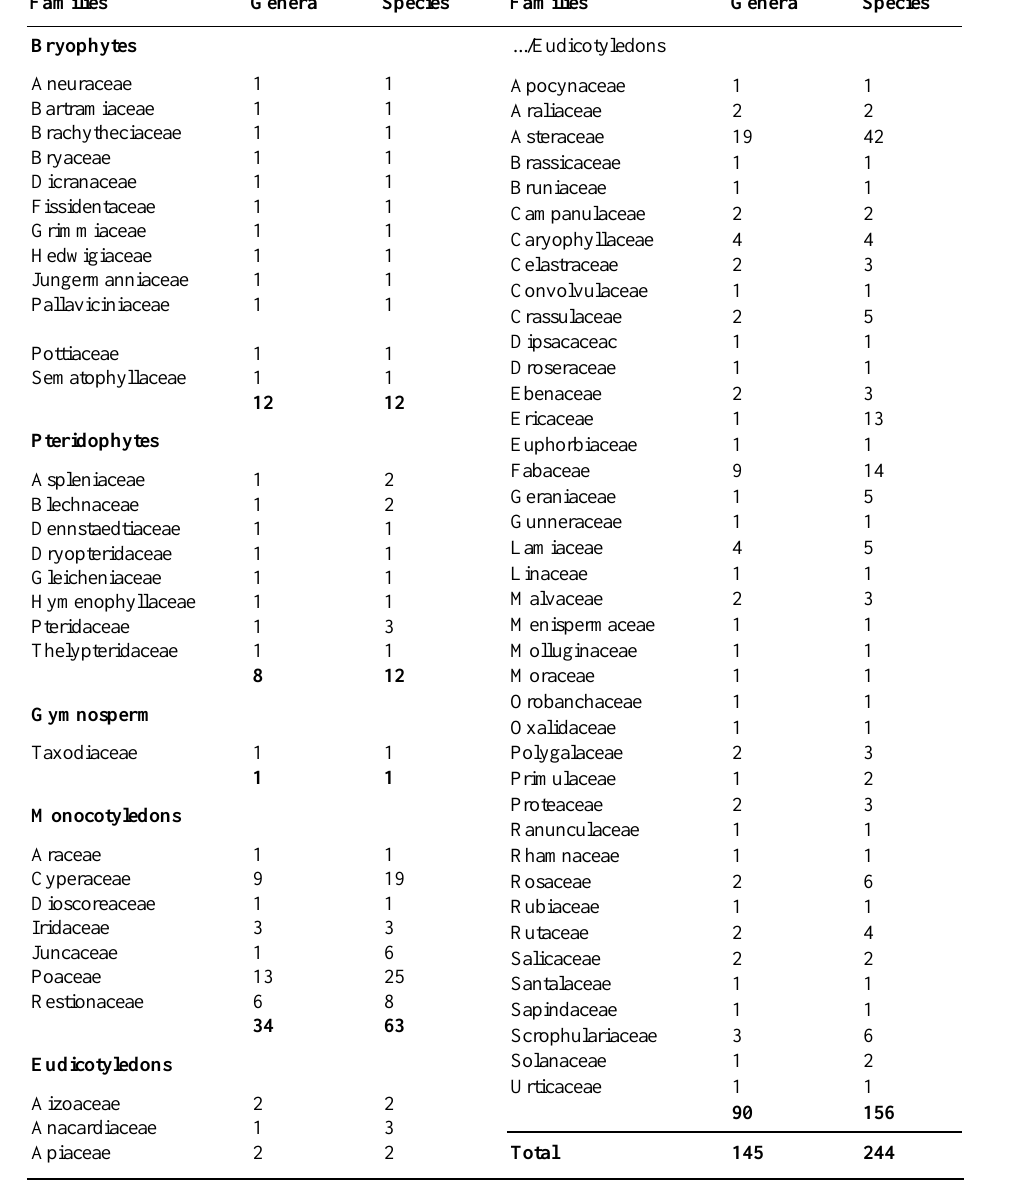
Table 2 An alphabetical list of plant families, collected at springs on the Kammanassie Mountain, indicating